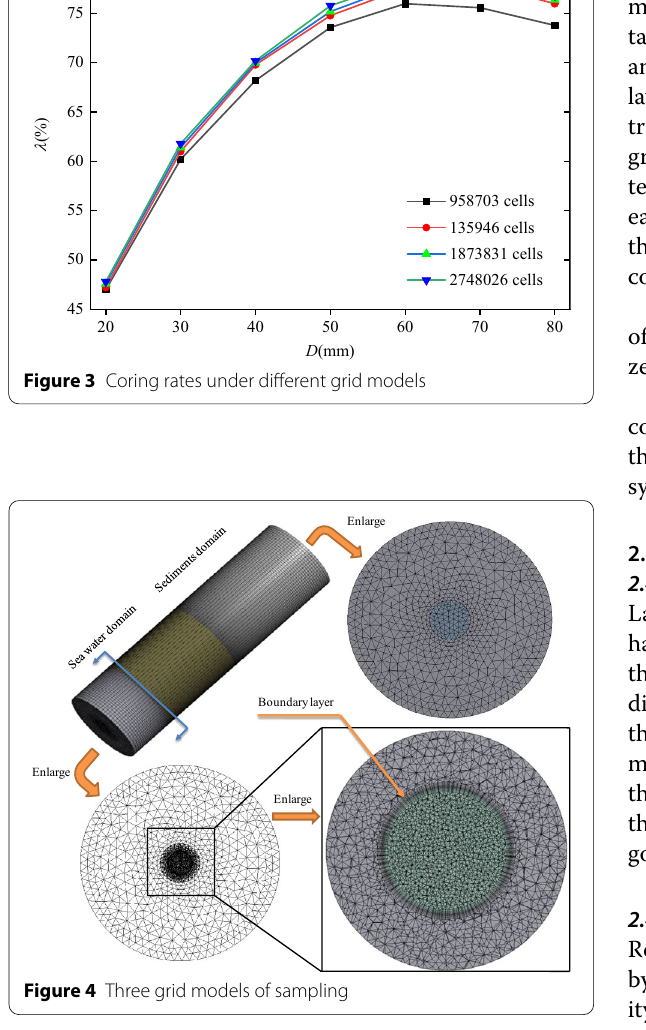
Figure 4 Three grid models of